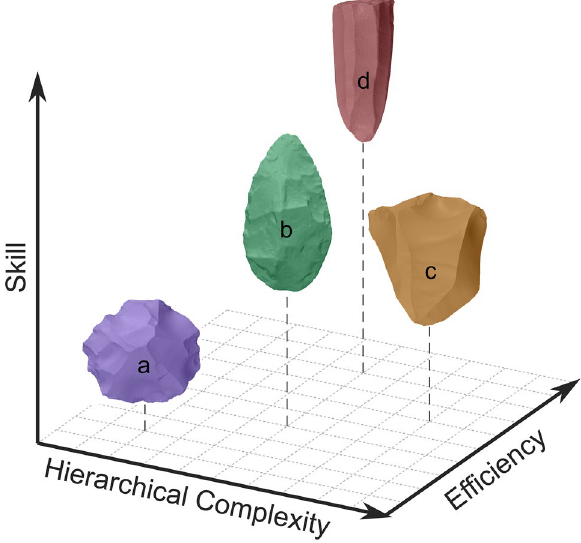
Figure 3. Visual approximation of the inherent traits of the technologies investigated here. 3D scatter plot of the skill, efficiency and hierarchical complexity involved in ( a ) discoidal, ( b ) handaxe, ( c ) Levallois, and ( d ) prismatic blade